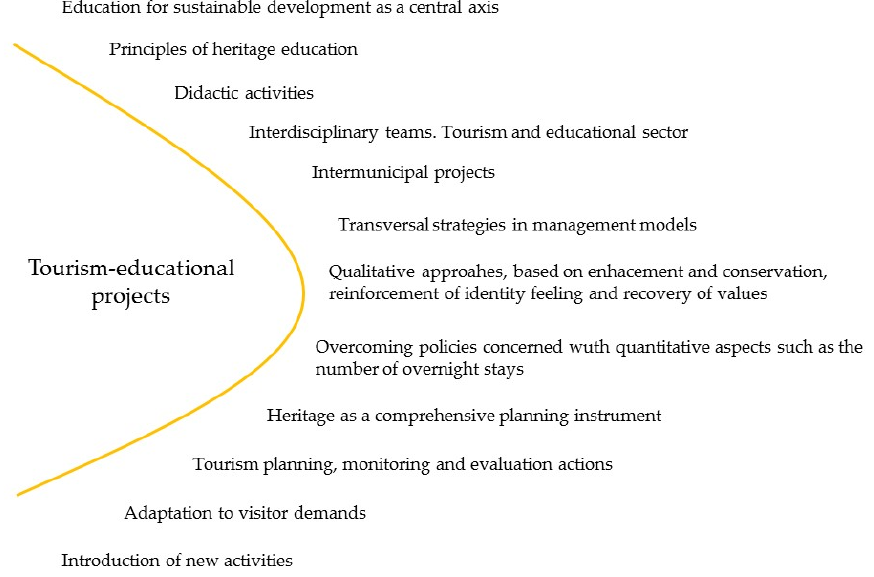
Figure 6. Characteristics of tourist-educational projects (Data from: